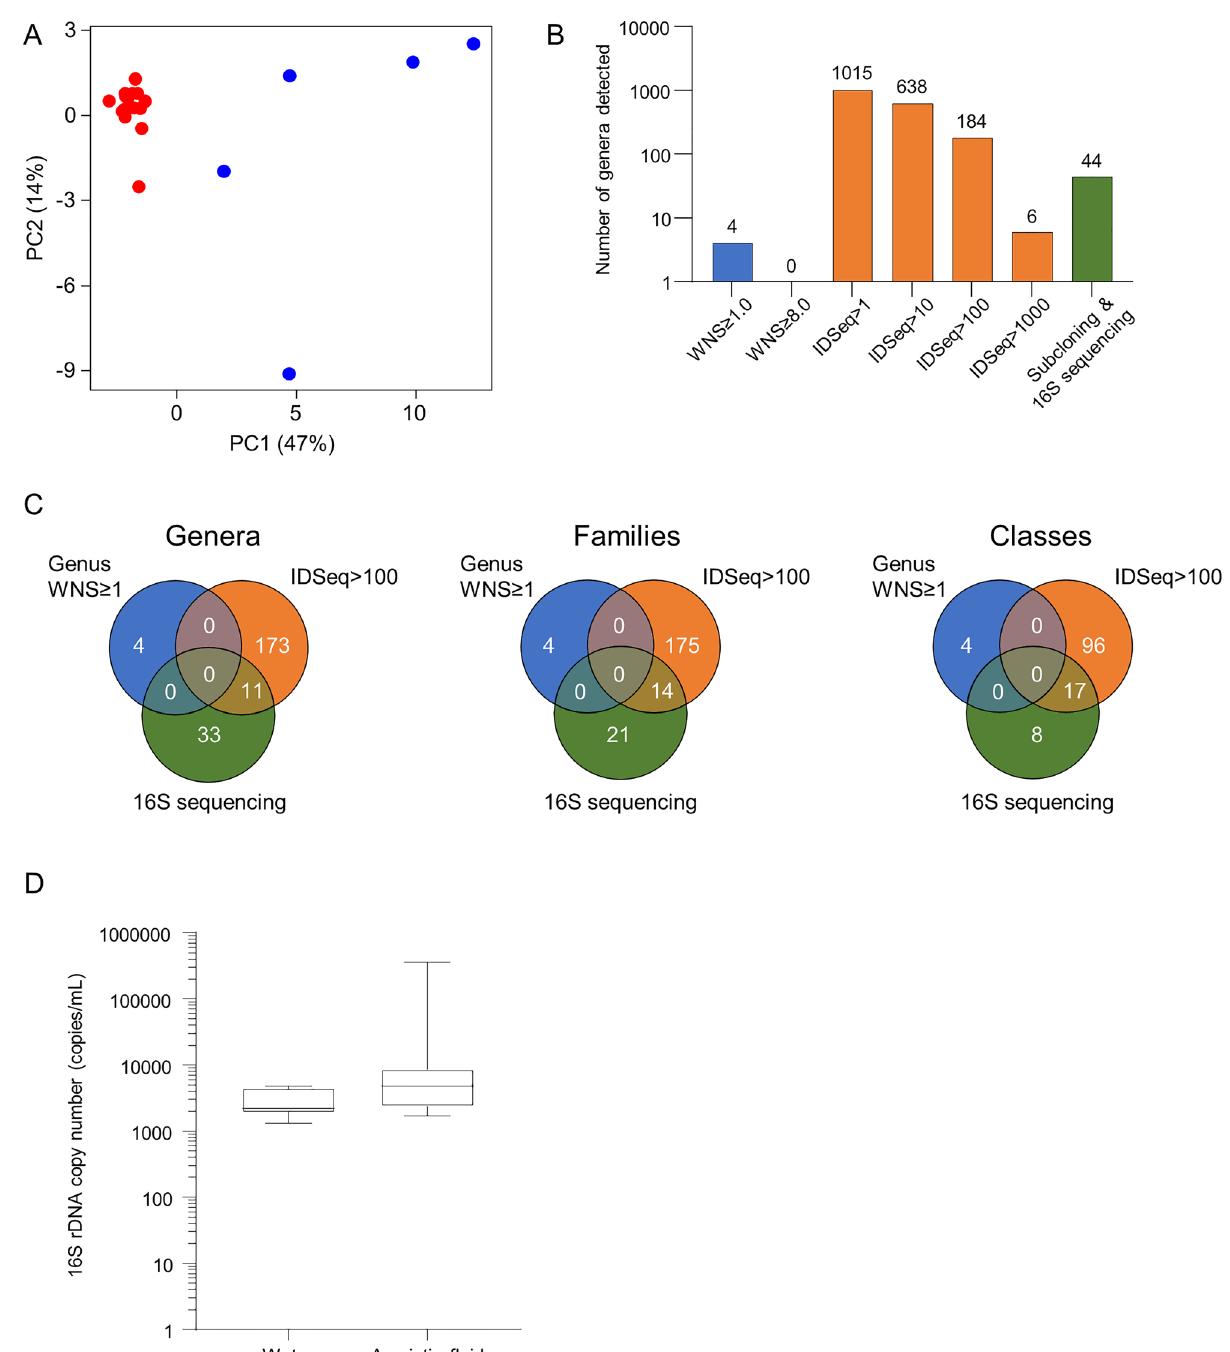
Figure 4. Microbial detection varies by method used. ( A ) Principal component analysis illustrating sample variance between water (blue) and amniotic fluid (red). ( B ) Bar graph showing the number of genera detected using our method (blue), IDSeq at different thresholds (orange), and 16S sequencing (green). ( C ) Venn diagrams comparing the number of genera, families, and classes detected in amniotic fluid samples using our method (blue), IDSeq (orange), and 16S sequencing (green). ( D ) EvaGreen 16S rDNA droplet digital PCR box plot comparing total volume of bacterial rDNA signatures in water controls and amniotic fluid (p > 0.05 for